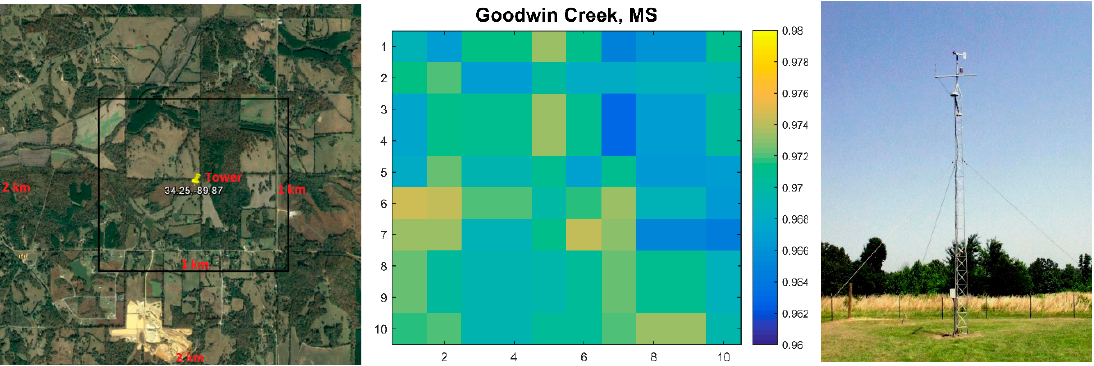
Figure 9. Satellite view of the 2 km by 2 km (whole map) and 1 km by 1 km box (black) near the Goodwin Creek site (left); middle figure shows the emissivity within 1 km of the site using ASTER GED data; right shows the tower.